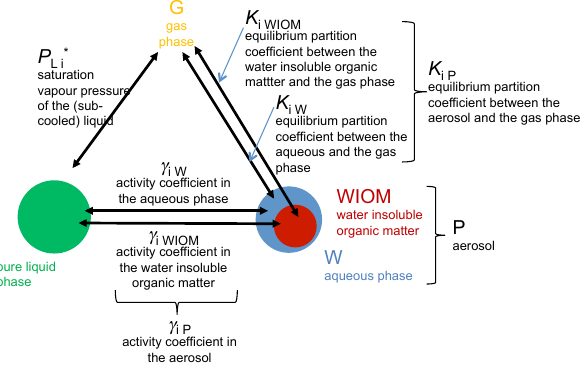
Figure 1. Thermodynamic cycle as it relates to the partitioning to atmospheric